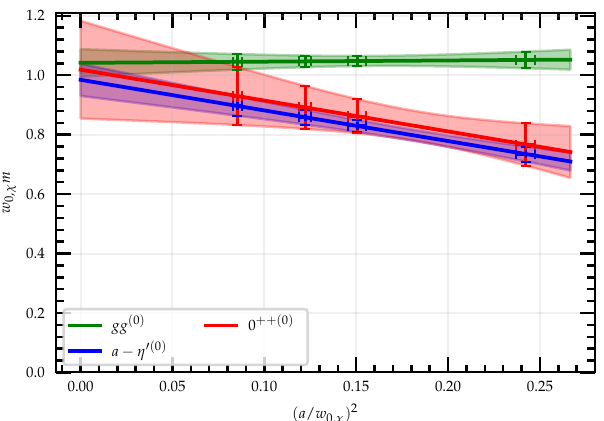
Figure 1. Bound state masses of SU(3) SYM in a simultaneous extrapolation to the chiral and continuum limits ( a → 0). The lightest bound states are expected to form a chiral multiplet consisting of a scalar 0 ++ , a pseudoscalar a − η (cid:48) , and a fermionic gluino–glue ( gg ) state. The upper index ( 0 ) indicates that it is the lightest state in each channel. Further details about the extrapolations and data are presented in